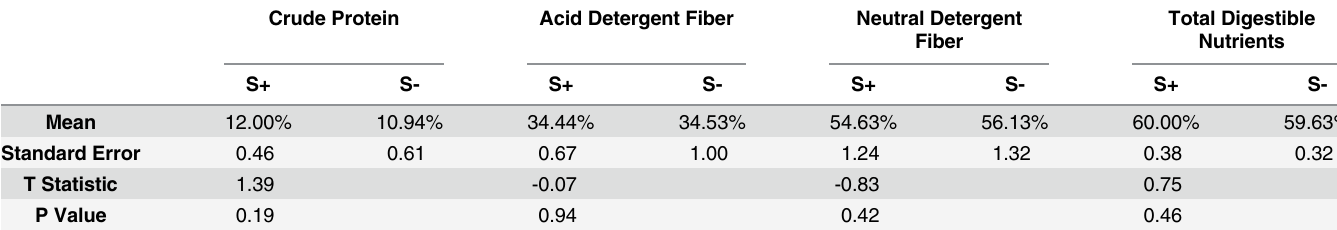
Table 1. Mean comparisons of forage attributes of Sordaria -infected (S+) and uninfected (S-) B . tectorum .